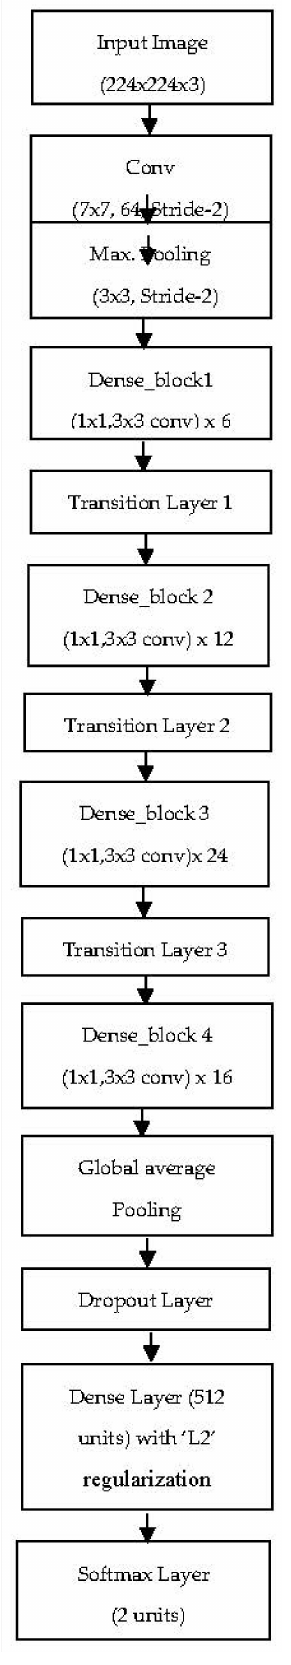
Figure 5. Architecture of fine-tuned DenseNet121